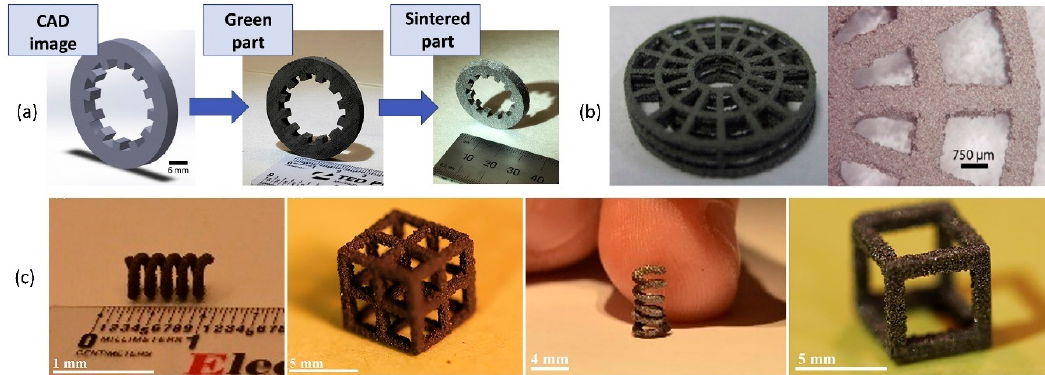
Figure 3. PBBJ 3D-printed parts. ( a ) Computer-aided design image to sintered part. Reproduced with permission from [92]; ( b ) PBBJ 3D-printed mesh structures with powder size < 20 µm. The designed width is 400 µm, and the measured width ranges from 650–770 µm. Reproduced with permission from [100]; ( c ) example of PBBJ 3D-printed components with complex shapes. Reproduced with permission from